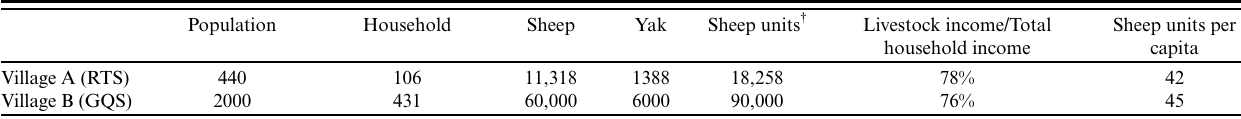
Table 1 . Socioeconomic characteristics of Village A and Village B. Note: RTS = rangeland transfer system, GQS = grazing quota system.